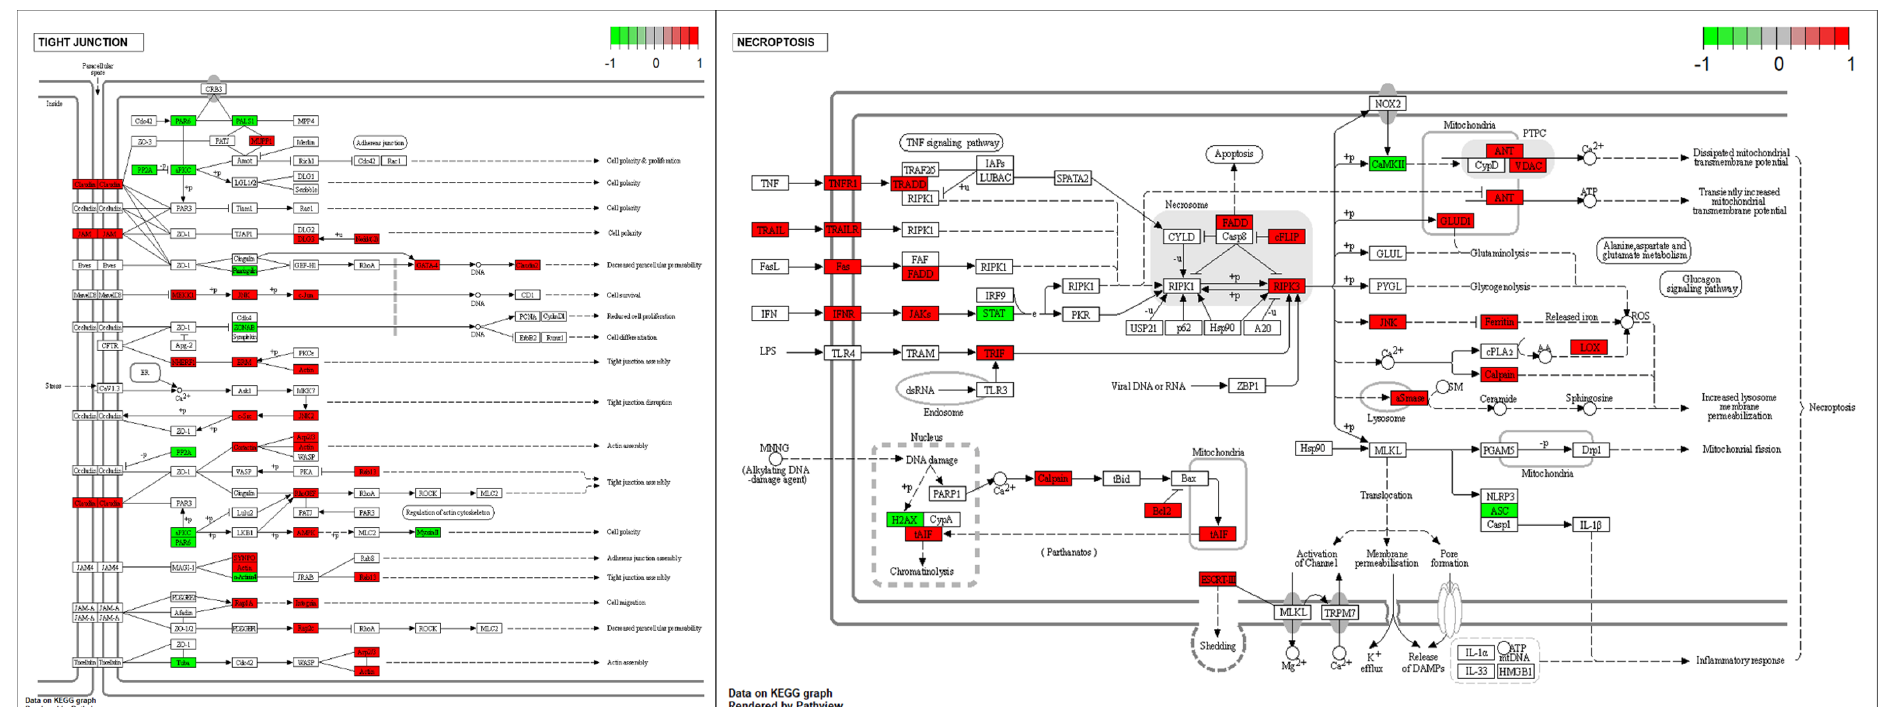
Figure 4. GO enrichment analysis. ( A ) The enriched GO biological processes. The GO annotations were divided into two groups namely activated and suppressed functions by R package clusterProfiler with gseGO function. The x -axis represents the gene ratio for each GO term. The circle size reflects the number of genes. ( B ) GSEA-based GO enrichment plots by R package enrichplot. Green line indicates the running enrichment scores. The bar color represents the activated (red) or suppressed (blue) functions. ( C ) The connection of genes among the prominent GO functions by enrichGO function. The circle color represents the different regulations of genes with log FC values (red; upregulation, green; downregulation). The arrow indicates CLDN11 gene.